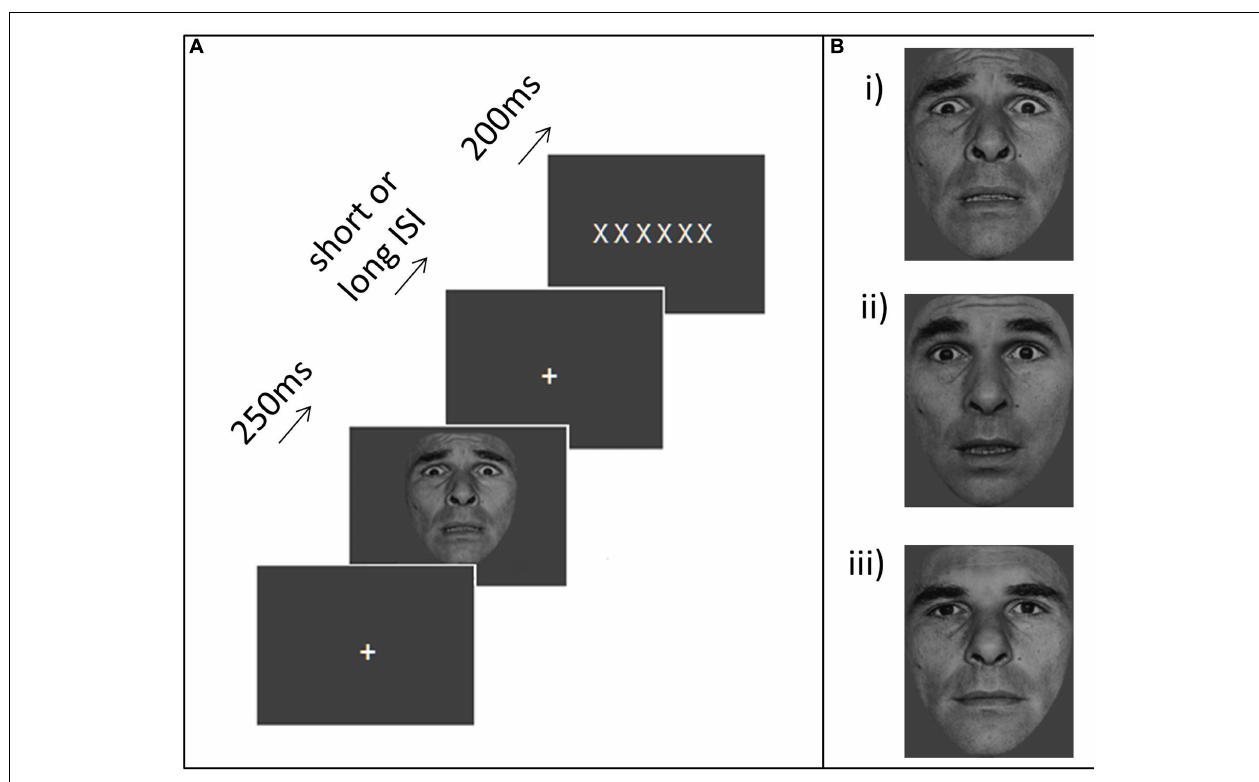
FIGURE 1 |Task and stimuli. (A) An example trial. Participants were asked to make speeded forced choice responses indicating whether a letter string comprised Xs or Ns. An irrelevant distractor – either a neutral face, moderate threat face (66% surprise, 33% fear) or strong threat face